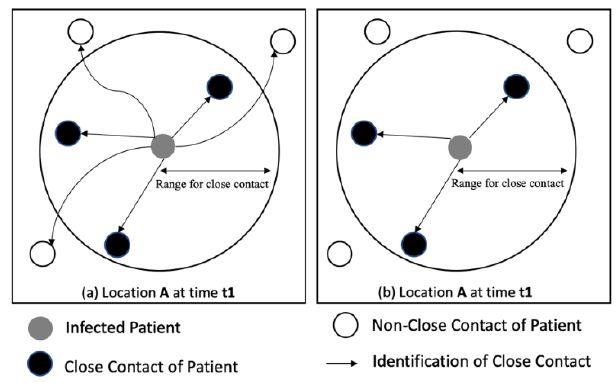
Figure 2. (a) Venue-based tracing; (b) Close contact